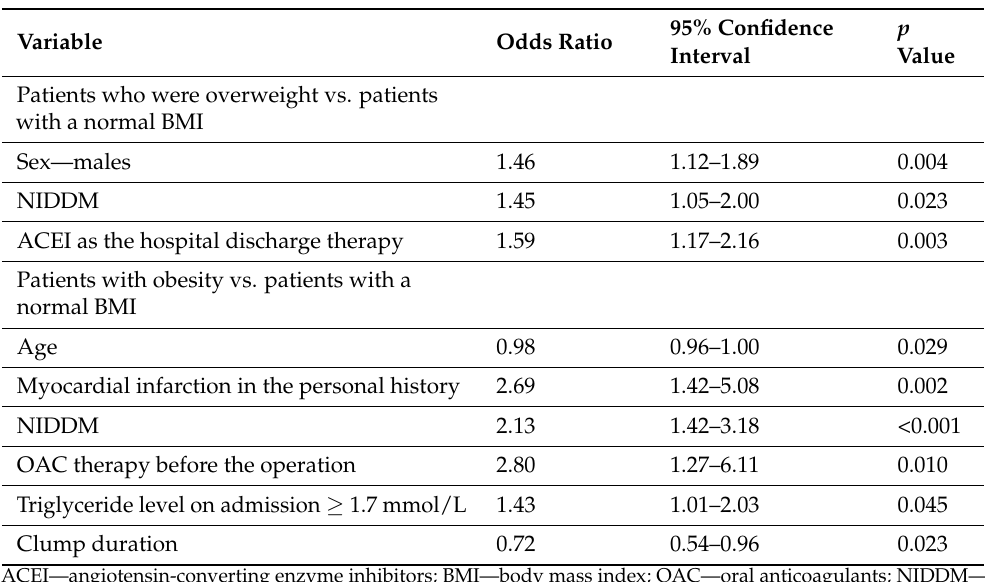
Table 5. Association of being overweight and having obesity with the occurrence of late major adverse outcomes (myocardial infarction, stroke, and death) and restenosis after carotid endarterectomies *.